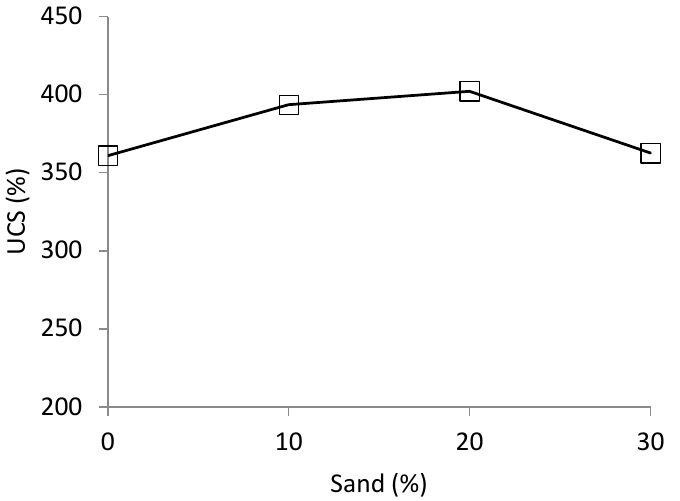
Figure 4. Effect of sand addition on UCS. Table 5. Plasticity characteristics for clay-sand